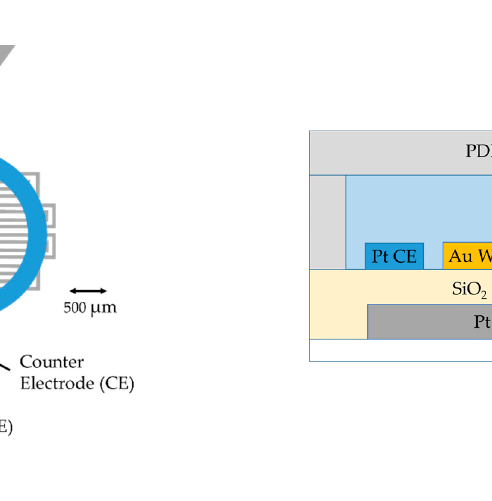
Figure 2. The electrochemical microscale platform architecture: ( a ) a top-view schematic of the platform (without the PDMS sample chamber); and ( b ) a side-view schematic (not to scale), including a sample well. The Pt heater/PRT fabricated on a glass wafer was isolated by a SiO 2 insulating layer. Au and Pt electrodes were fabricated by two lift-off e-beam evaporated depositions. The PDMS chamber and lid were centered above the electrode system.